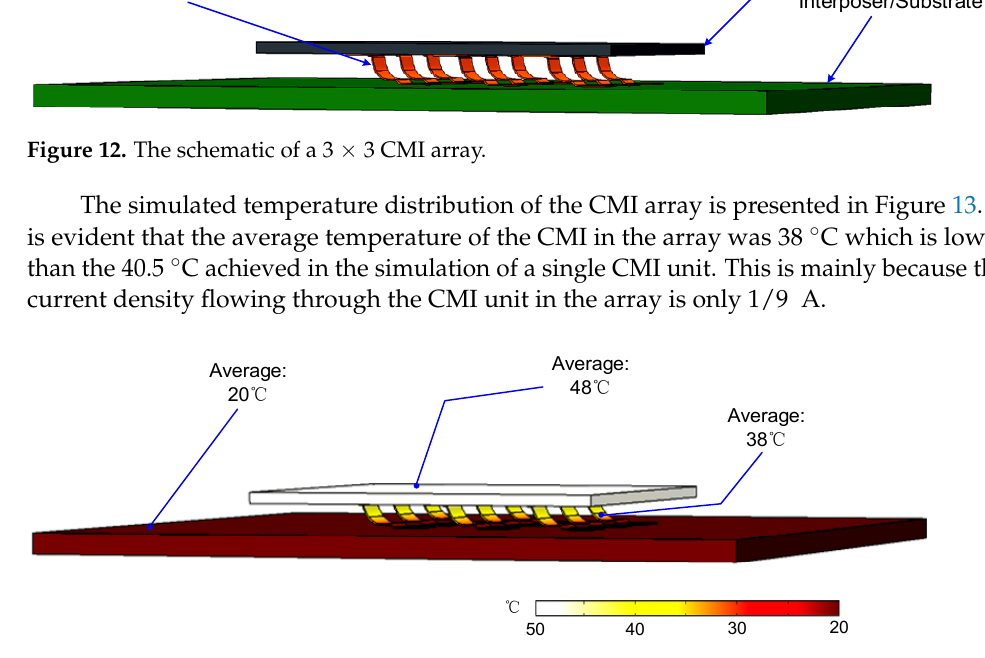
Figure 11. Temperature distributions of contact plane: ( a ) initial and ( b ) optimized.